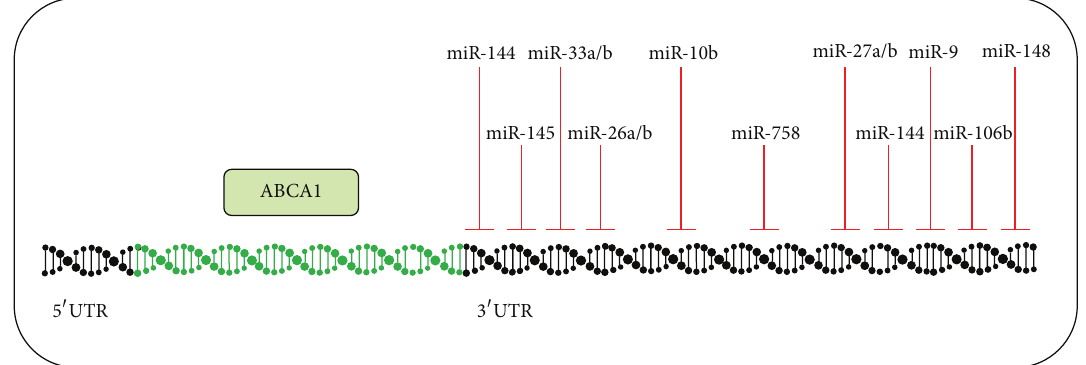
Figure 3: MicroRNAs targeting ABCA1 mRNA. This figure summarizes all currently validated miRNAs which target ABCA1 mRNA and are thus involved in cholesterol transport. The inhibition of these miRNAs holds great therapeutic potential in increasing circulating HDL cholesterol